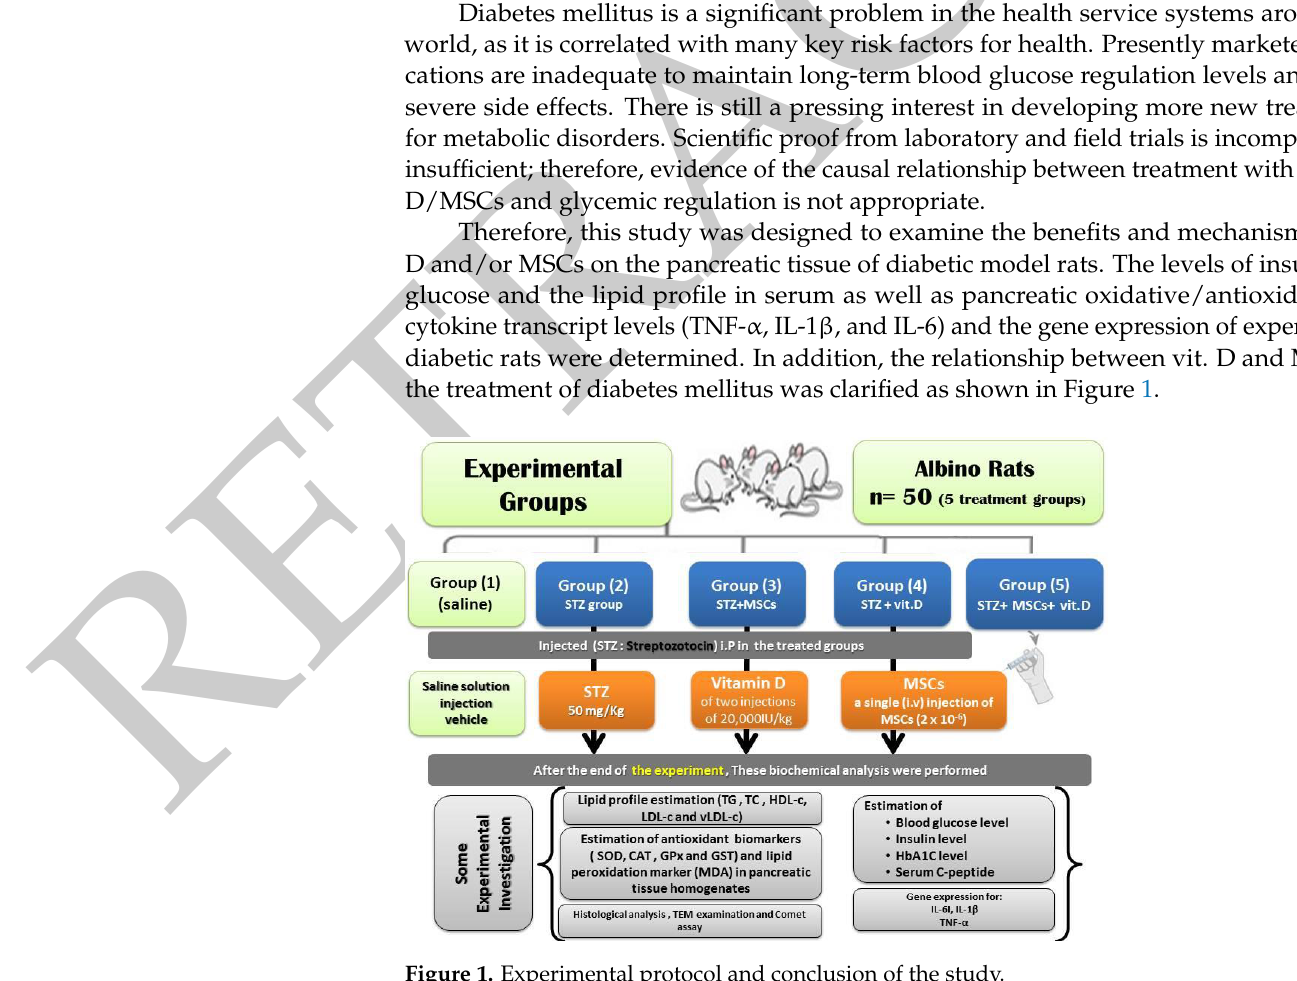
Figure 1. Experimental protocol and conclusion of the study.